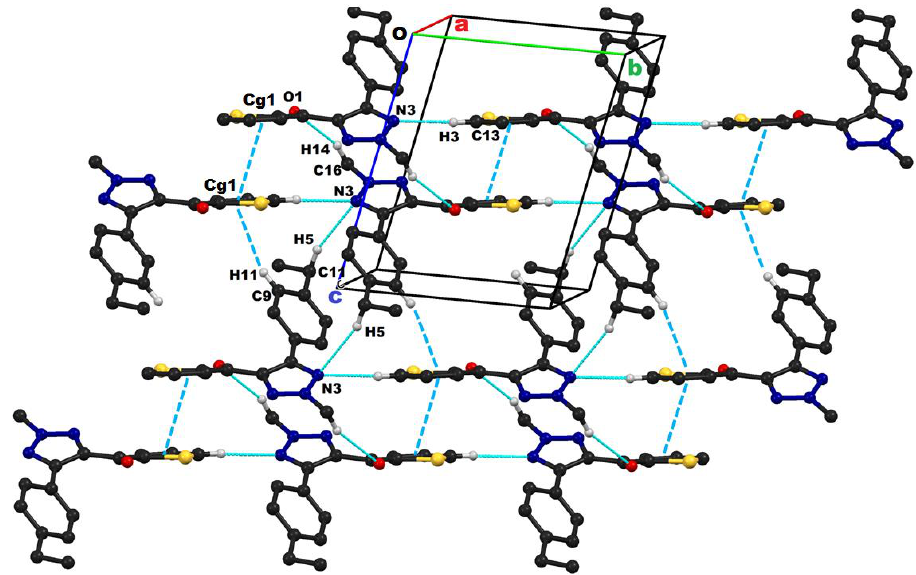
Figure 4. Packing of molecules down the bc plane associated with C-H···O, C-H···N, C-H···Cg1, and π···π stacking (Cg1···Cg1) interactions. All non-interacting hydrogen atoms were removed for clarity.